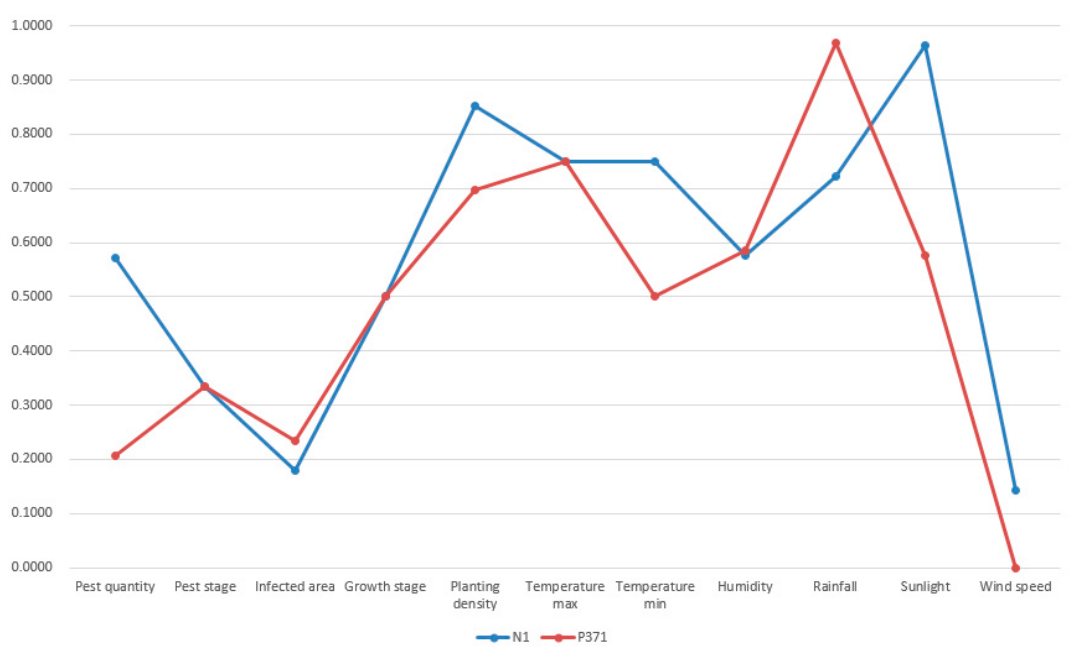
Figure 14. Visualization of the new case 1 and past case 14. Sensors 2019 , 19 , x FOR PEER REVIEW